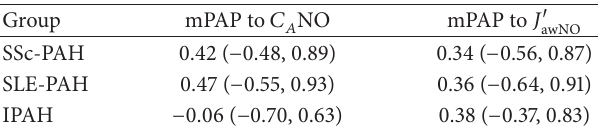
Table 6: Correlation between alveolar NO, conducting airway NO, and mean pulmonary artery